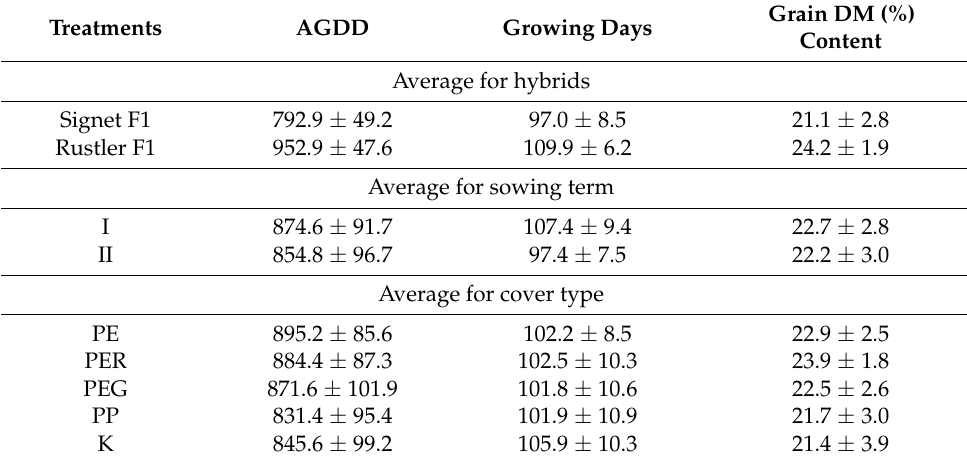
Table 1. Accumulative growing degree days (AGDD) for sweet maize growing season, vegetation period (in days), and average grain dry matter (DM) content. Average and standard deviation for